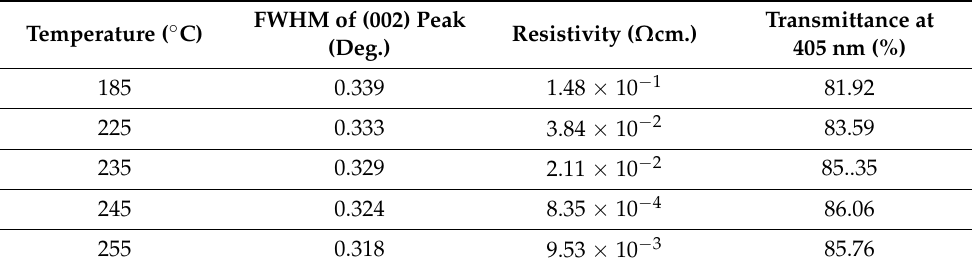
Table 2. The 2 θ angle and FWHM of (002) peak of XRD spectra, resistivity, and transmittance at 405 nm of MIPEMOCVD-grown GZO with varying deposition